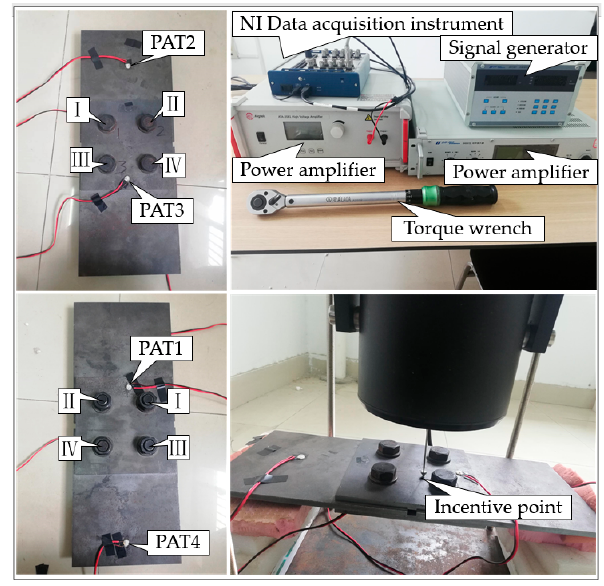
Figure 5. Experimental setup.